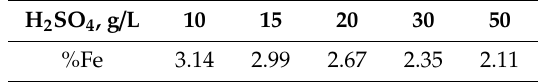
Table 2. Total iron concentration in leach residues at different concentrations of H 2 SO 4 .